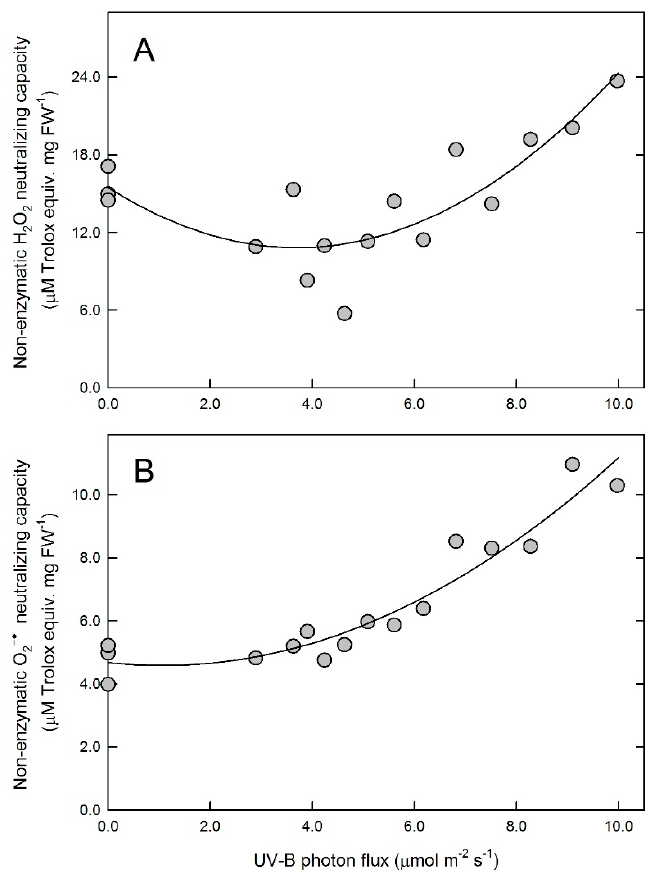
Figure 5. Changes in non-enzymatic hydrogen peroxide ( A ) and superoxide anion radical neutralizing ( B ) capacities. Symbols represent data of individual leaves and lines show the results of a second order polynomial fit characterized by p < 0.001 for both data sets.